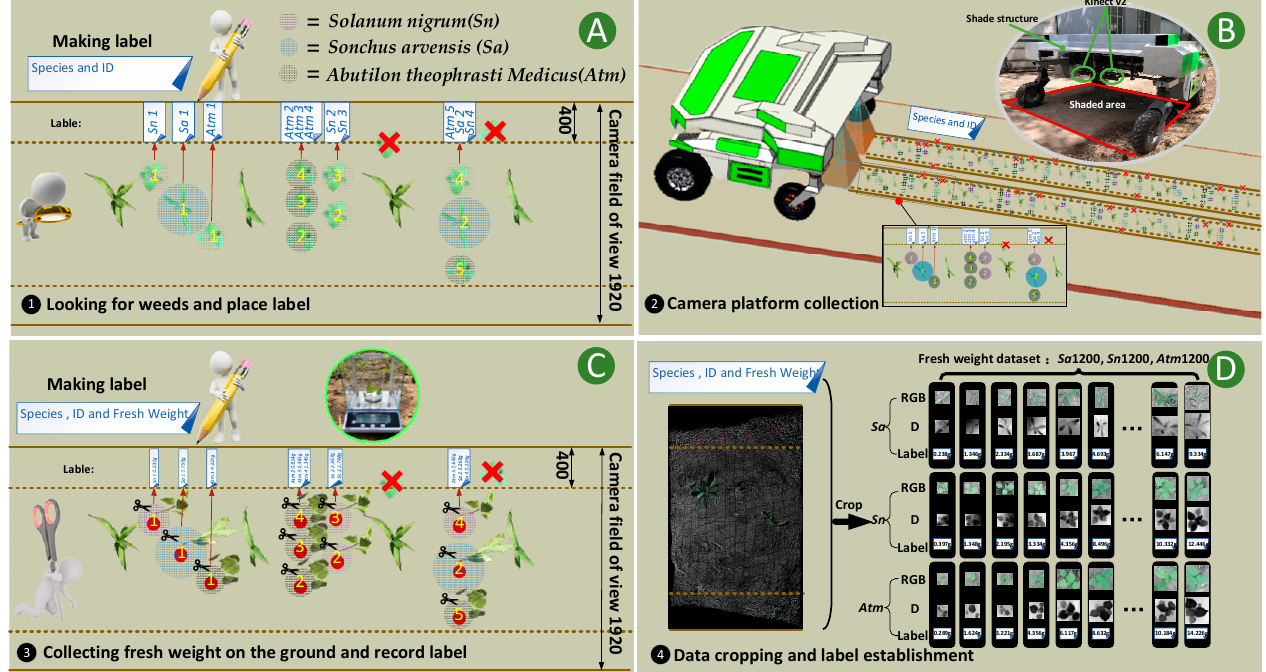
Figure 1. Data collection process. ( A – D ) correspond to each of the four steps of the collection method in this section. The solid line in the figure represents the field of view of the camera, and the dotted line represents the range of the setting line. The different colored circles represent the respective categories of weeds. The weeds marked with a red cross in the picture represent no recording and collection. In Figure 1D, weeds are sorted from left to right according to leaf age and growth size. A detailed enlarged image is shown in Figure A1 in the Appendix to this paper.